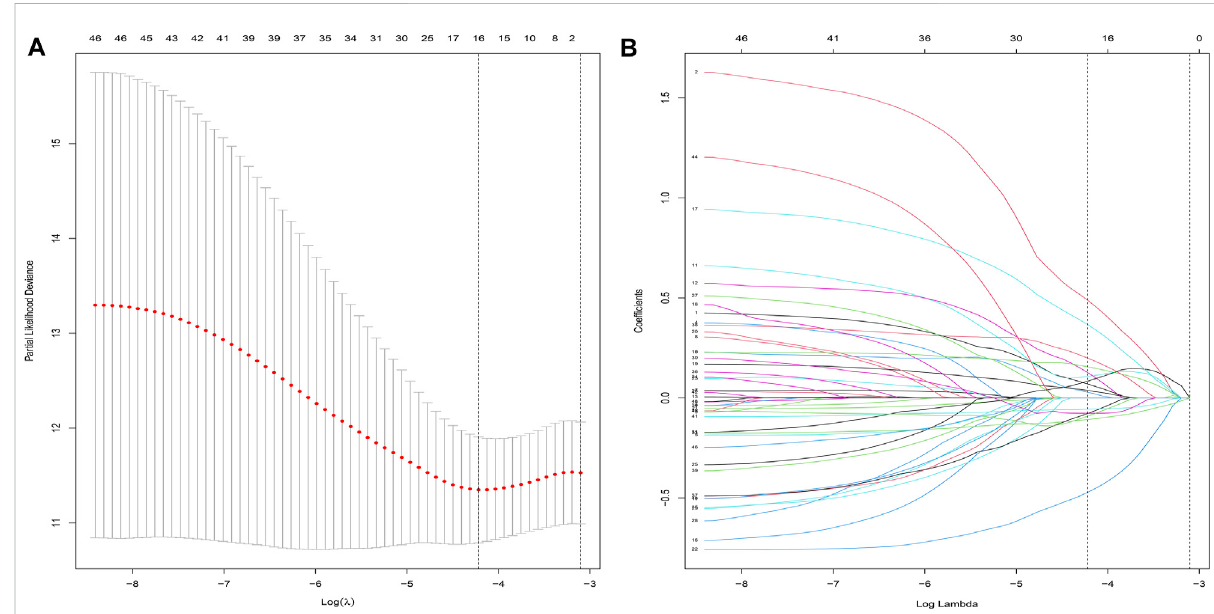
FIGURE 3 LASSOregressionanalysis. (A,B) Lassoregressionwasusedtoconstructprognosticsignaturesinthetrainingcohort( n =525).WhenLamdawas 16, the curve converged.